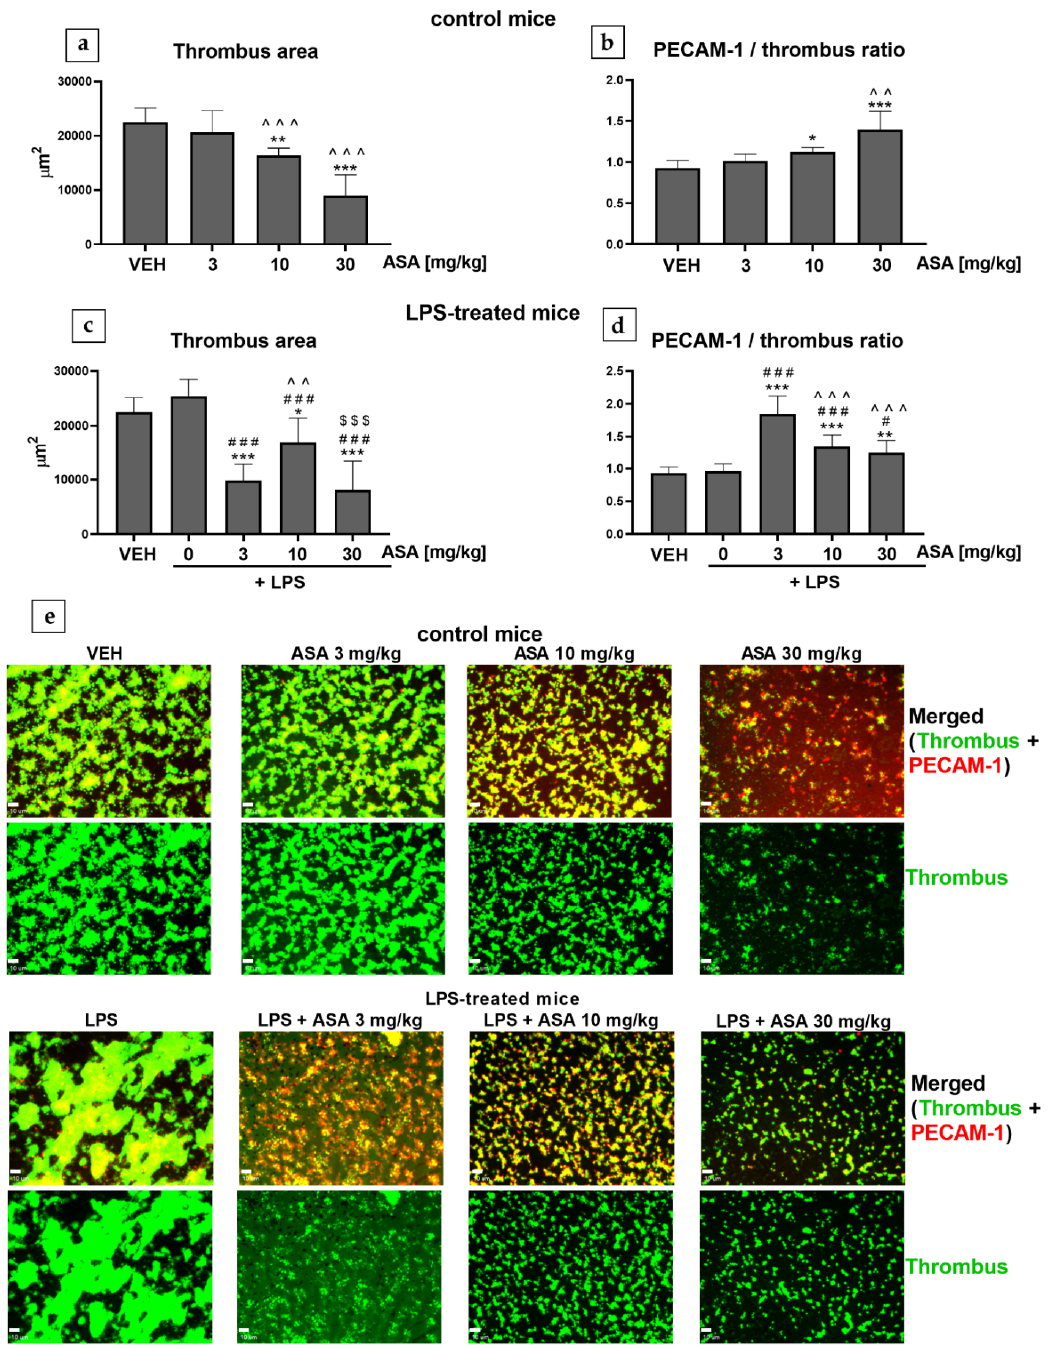
Figure 2. Effect of ASA (ex vivo) on ( a ) thrombus area and ( b ) PECAM-1/thrombus ratio in mice without inflammation (control mice) and on ( c ) thrombus area and ( d ) PECAM-1/thrombus ratio in mice with inflammation (LPS-treated mice). ( e ) Top panel, control mice; bottom panel, LPS-treated mice; original, representative confocal microscopy images of merged channels (green, thrombus; red, PECAM-1, top row in each panel) and thrombus (green, bottom row in each panel) (bar = 10 µ m; * p < 0.05, ** p < 0.01, *** p < 0.001 vs. VEH; # p < 0.05, ### p < 0.001 vs. LPS; ˆˆ p < 0.01, ˆˆˆ p < 0.001 vs. LPS + ASA 3 mg/kg; $$$ p < 0.001 vs. LPS + ASA 10 mg/kg; n = 9 − 13). Data are shown as mean ±